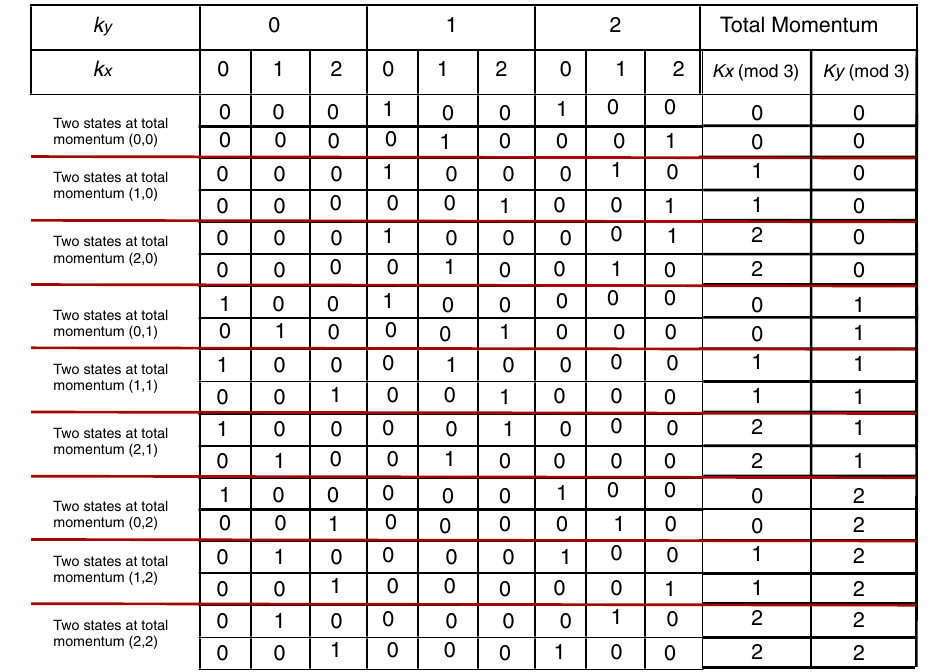
FIG. 11. Example of total momentum counting for the quasiholes of the N ¼ 2 , N x ¼ N y ¼ 3